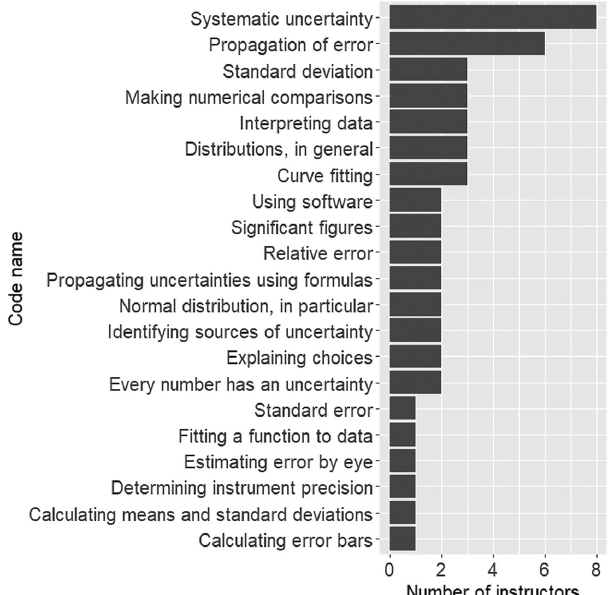
FIG. 6. The number of interviews ( N structors mentioned topics that they chose not to cover or emphasize, broken down by the emergent codes in Tables IV and V.